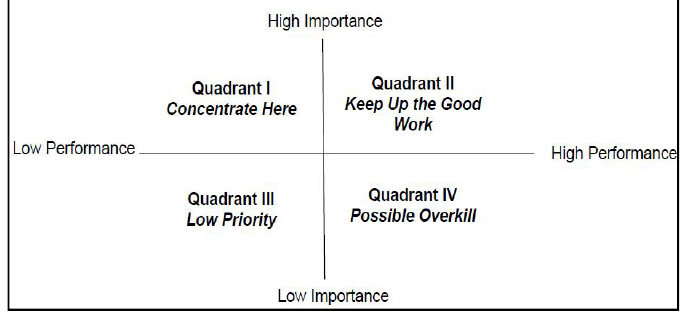
Fig.1 The Original IPA Framework